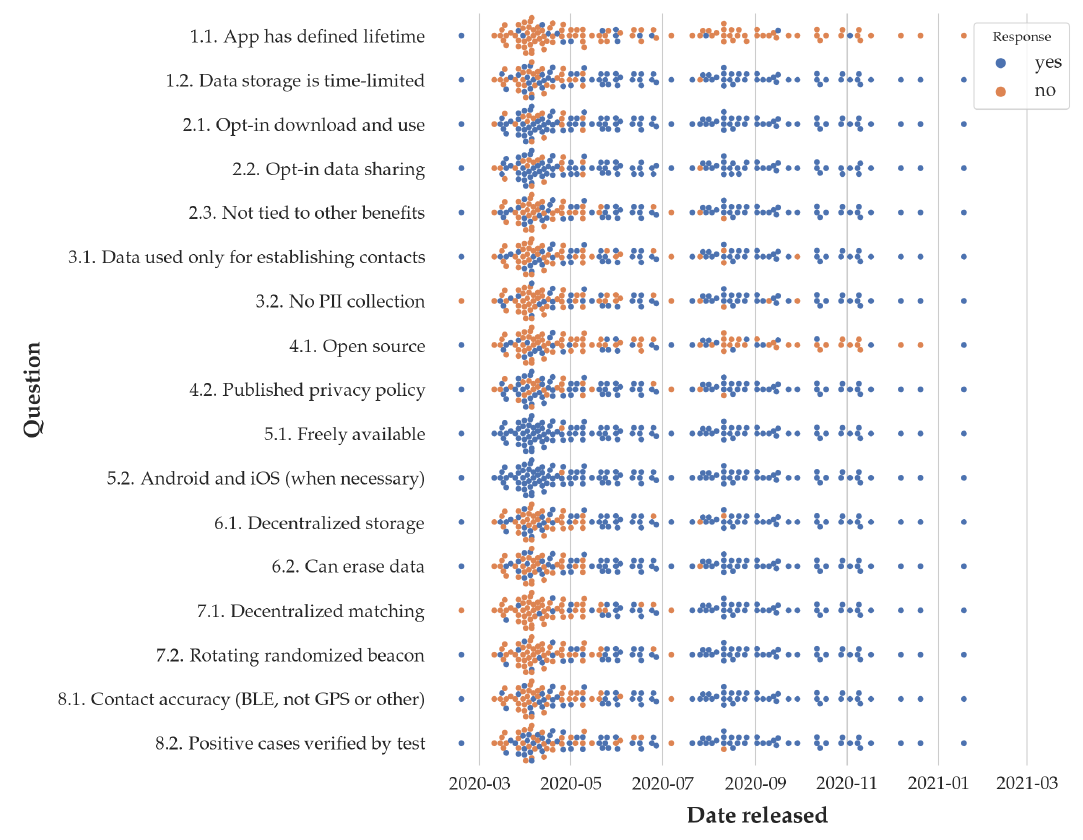
Figure 8. App scores disaggregated by question and release date. Each column represents a single application, while each dot represents the value of that application for each question (rows); blue indicates the app satisfies the criterion, orange indicates the app does not satisfy the